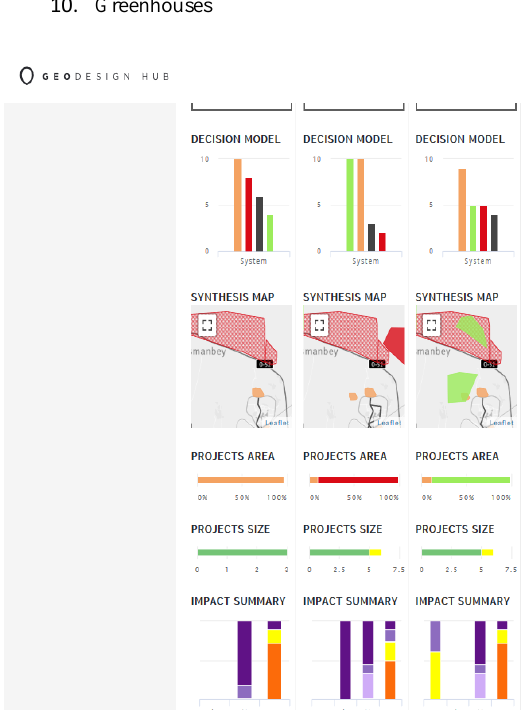
Figure 4. Geodesign Hub showing 3 development scenarios